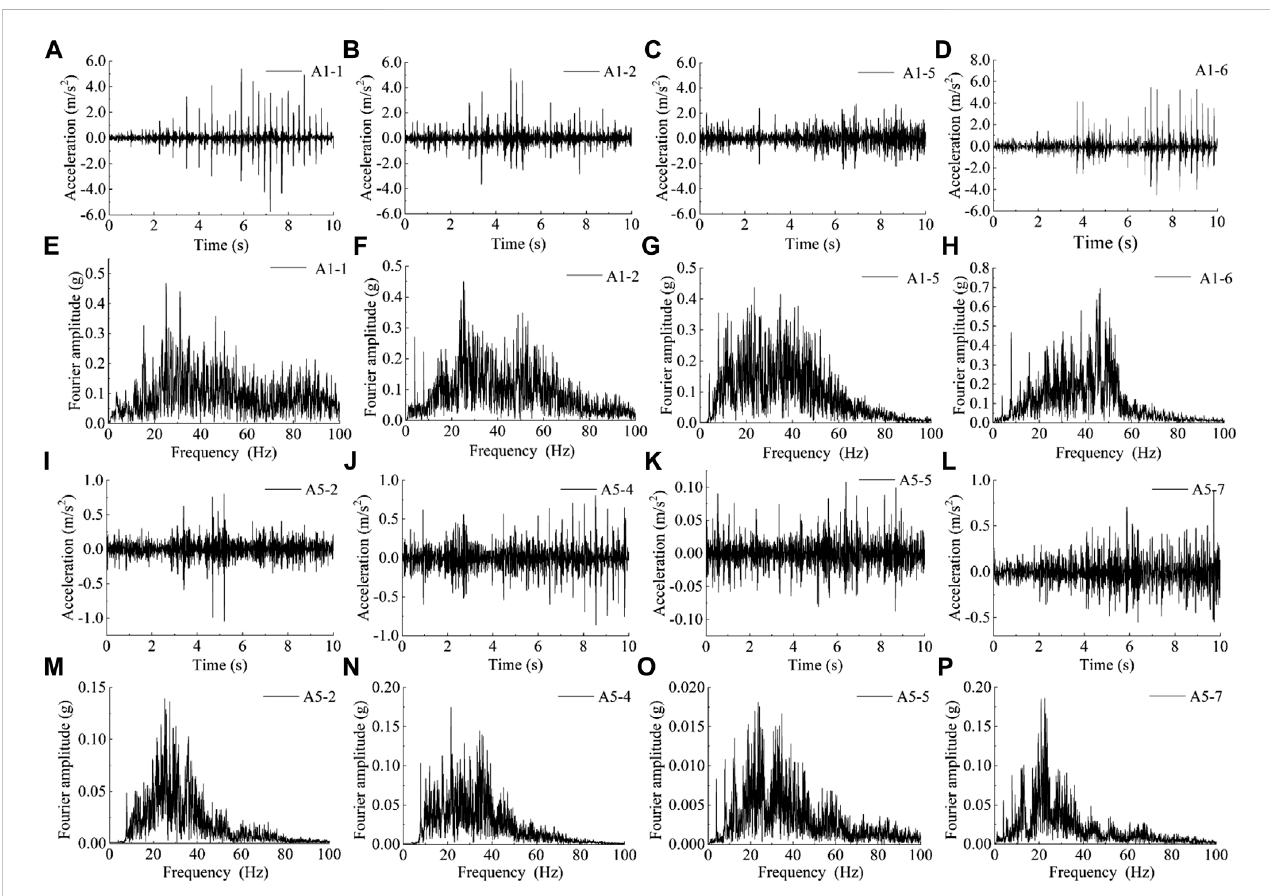
FIGURE 8 Acceleration-time curves and Fourier spectrum of acceleration in subgrade (A – H) and in foundation soil (I – P) .